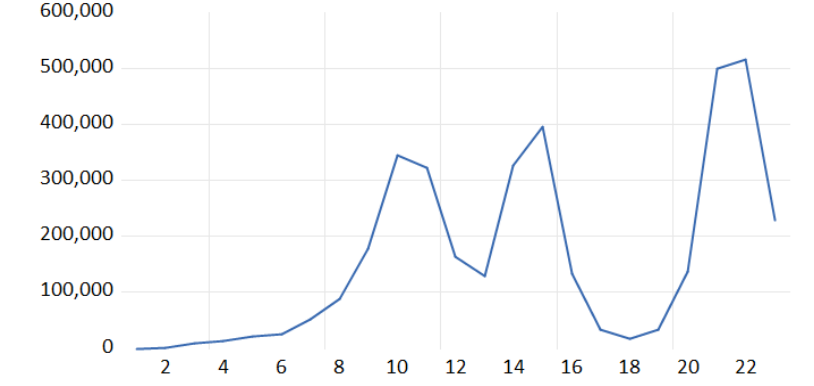
Figure 1. Dynamics of changes in the indicator “number of infected persons with the Covid-19 coronavirus infection” per